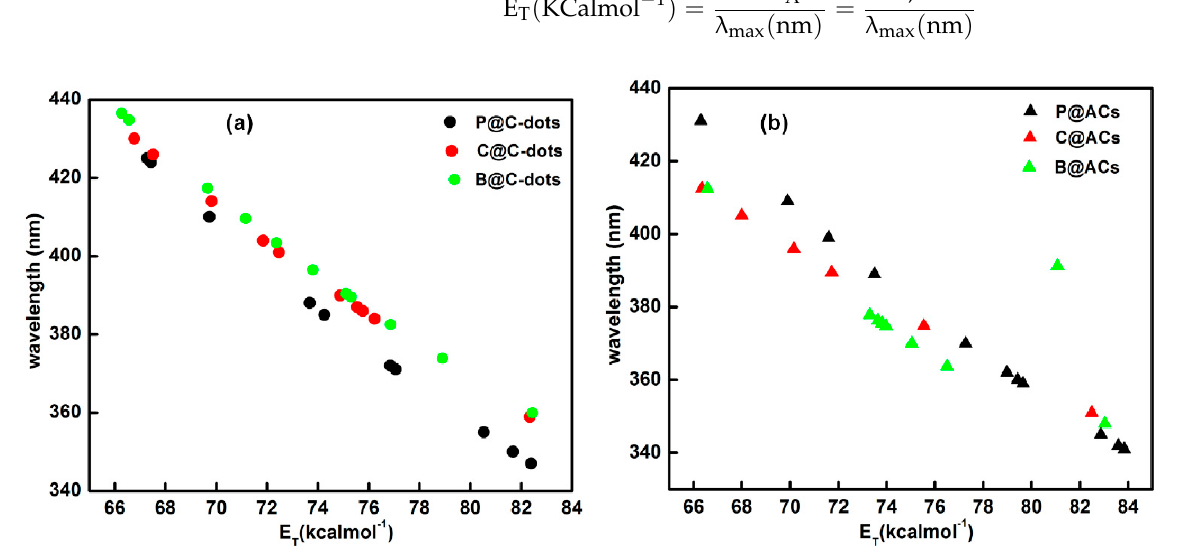
Figure 8. Variation of wavelength and E T parameters for C-dots ( a ) and their counterpart ACs ( b ) derived from polybags, cups and bottles. ( b ) derived from polybags, cups and